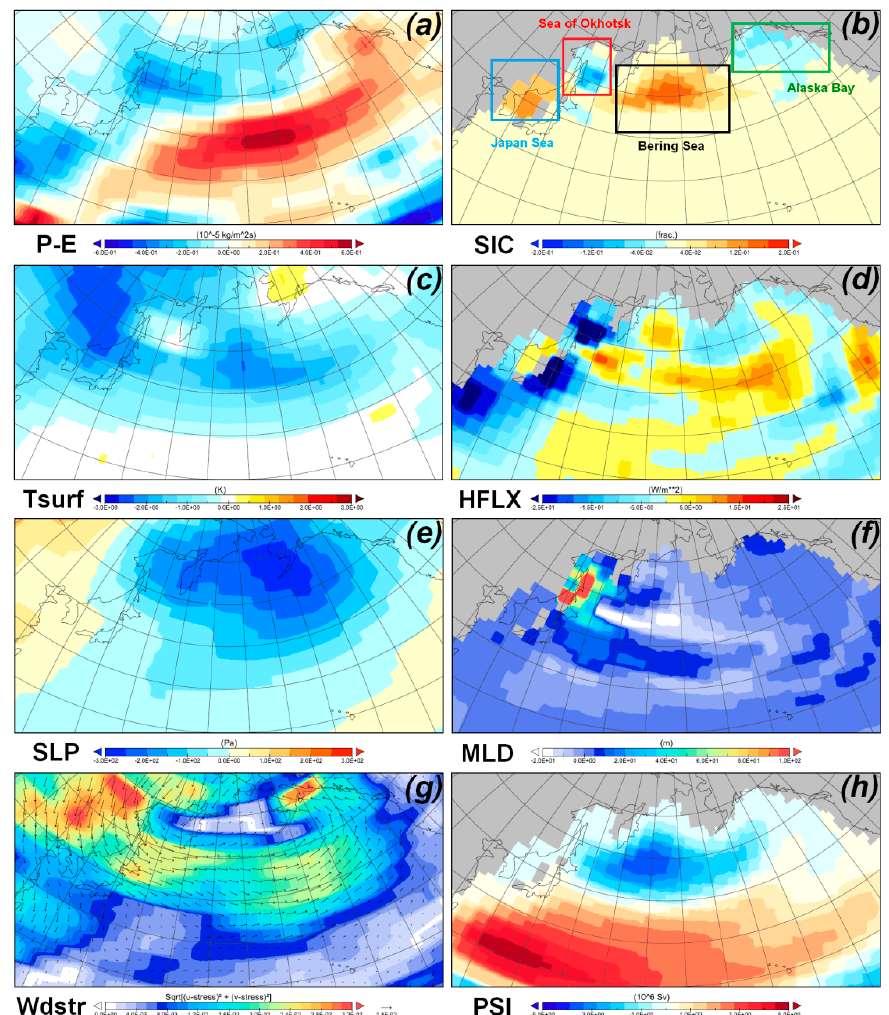
Figure 5. Simulated annual mean surface oceanic and atmospheric anomaly of the Heinrich Event 1 (H1) with respect to the Last Glacial Maximum (LGM). ( a ) P-E: precipitation minus evaporation, ( b ) SIC: sea ice concentration, ( c ) Tsurf: surface atmosphere temperature, ( d ) HFLUX: total heat flux out of the ocean, ( e ) SLP: sea level pressures, ( f ) MLD: mixed-layer depth, ( g ) Wdstr: wind stress, and ( h ) PSI: horizontal stream function. Units are given in the color-coded bars below the figures.